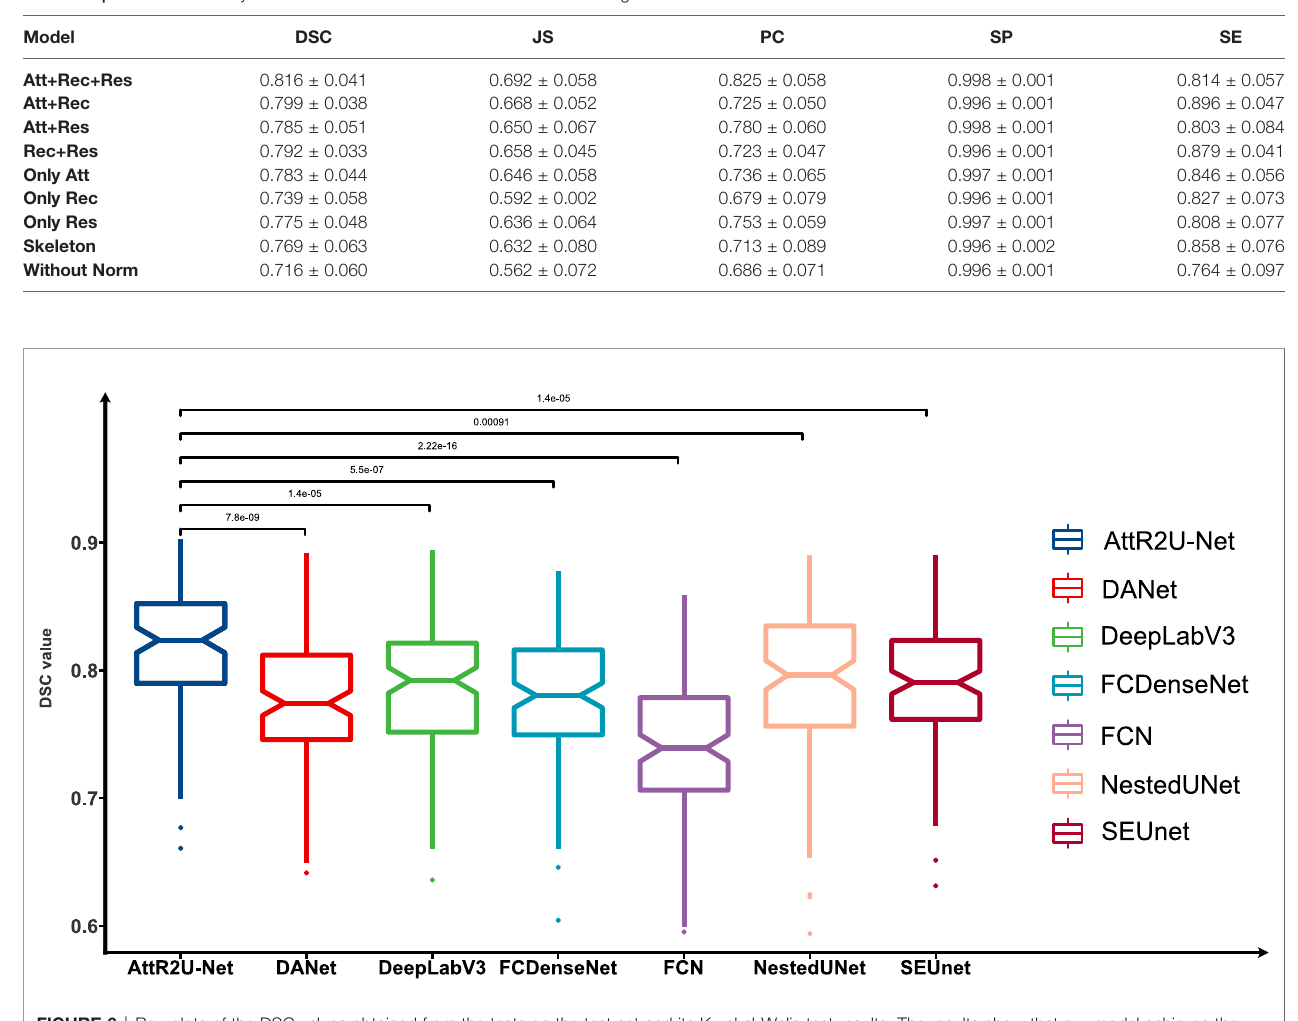
FIGURE 6 | Box plots of the DSC values obtained from the tests on the test set and its Kruskal-Walis test results. The results show that our model achieves the highest DSC values in the test of nasopharyngeal carcinoma segmentation and is signi fi cantly different from other